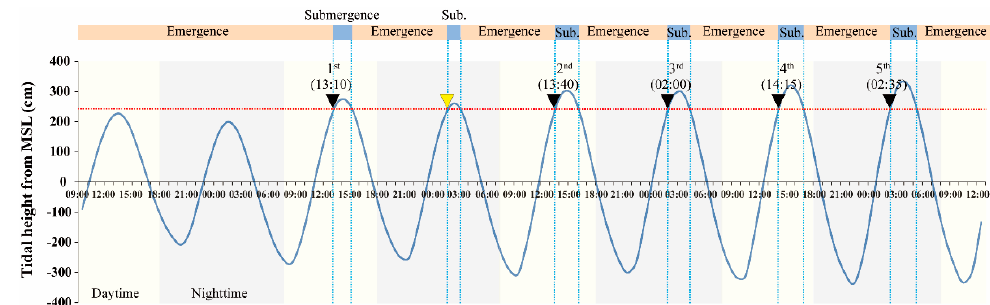
Figure 3. Sampling times for collecting expelled sediments by tidal height from MSL. Black triangles represent the time LM4 (243 cm from MSL, dotted red line) began to submerge. The collection process was conducted in the submerged period (yellow triangle) between 1st and 2nd submergence events; however, data were not included because LM1, LM2, and LM3 were not submerged at that period.